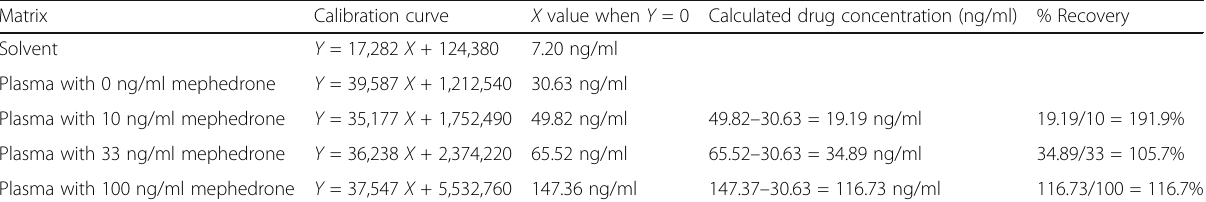
Table 2 Accuracy of quantifying mephedrone in plasma using standard addition method Matrix